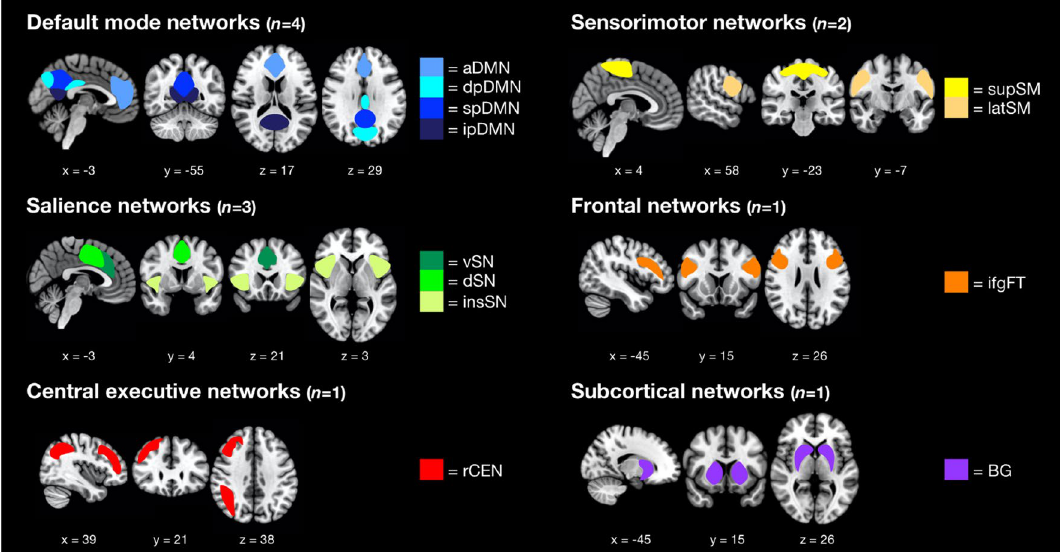
Figure 1. Composite maps of the resulting 12 network components sorted into 6 large-scale networks as displayed on a Montreal Neurological Institute template taken from ICBM 152 Nonlinear atlases version 2009 (© 1993–2004 Louis Collins, McConnell Brain Imaging Centre, Montreal Neurological Institute, McGill University) 43 (schematic display). Visualized with help of MRIcroGL v1.2.20210317 (https:// www. nitrc. org/ proje cts/ mricr ogl) 44 . aDMN anterior default mode network, dpDMN dorsal posterior default mode network, spDMN superior posterior default mode network, ipDMN inferior posterior default mode network, vSN ventral salience network, dSN dorsal salience network, insSN insular salience network, rCEN right central executive